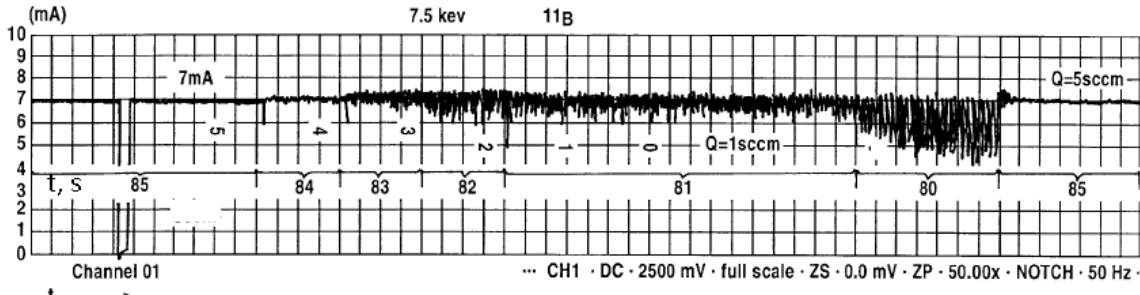
Figure 7. Photograph of 11 B + beam after analyzer without electronegative gases and with electro- negative gases.